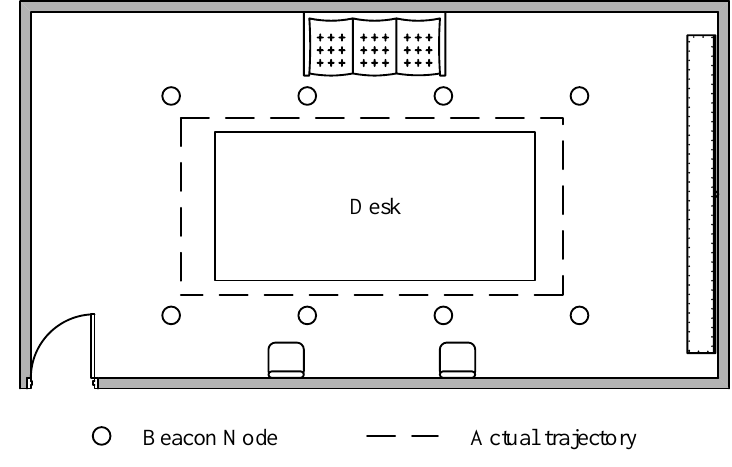
Figure 20. The floor plan for the test bed.